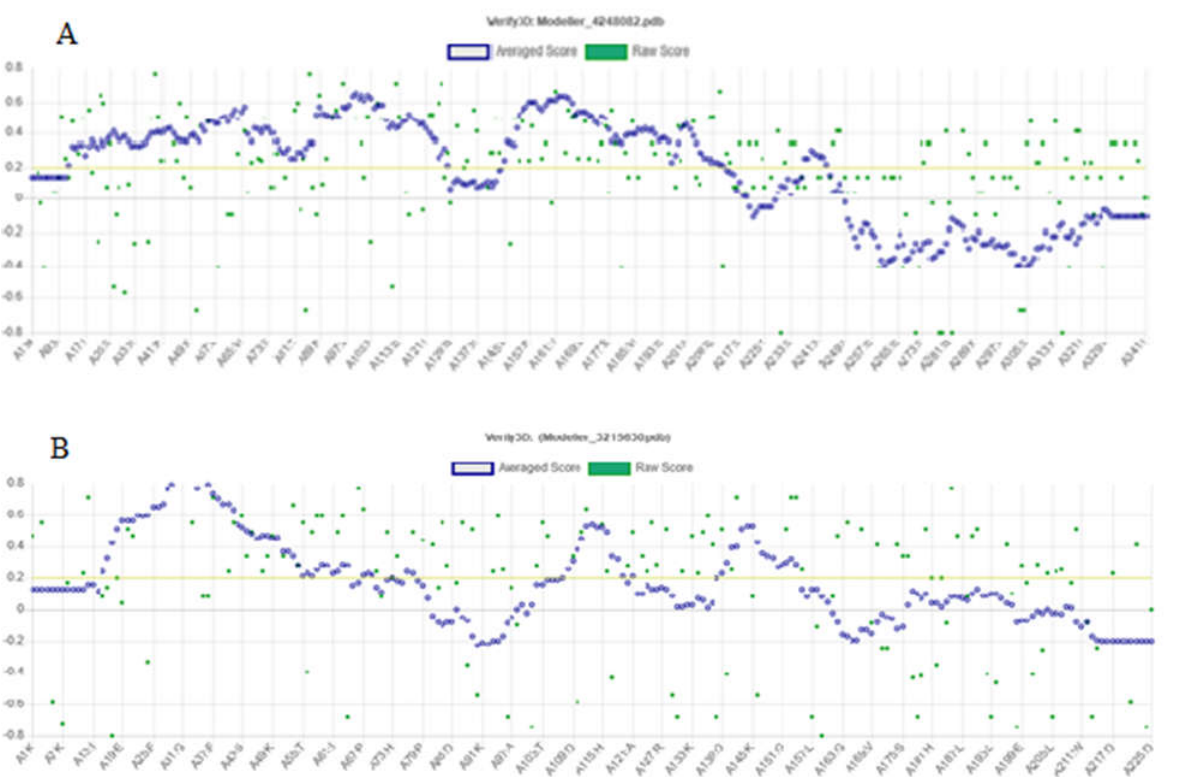
Fig.4. The model quality obtained by VERIFY3D : A) LOC105974023; B)